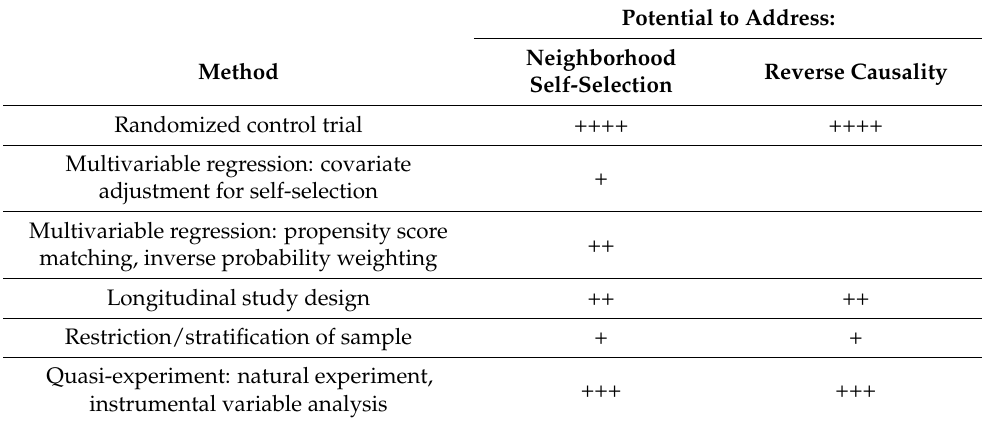
Table 2. Methods to address self-selection and reverse causality in neighborhood environment and brain health